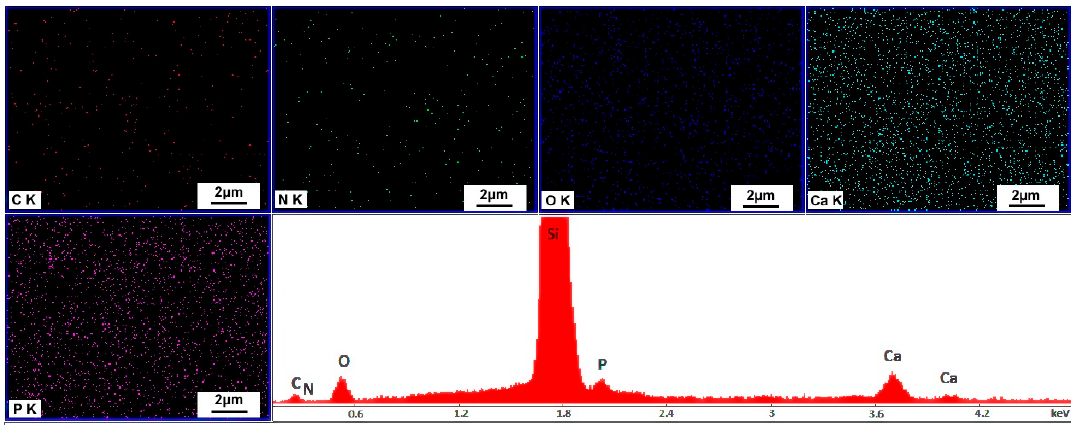
Figure 5. Elemental mapping and typical EDX spectrum of CS–HAp coatings obtained at p = 5 × 10 − 3 mbar.